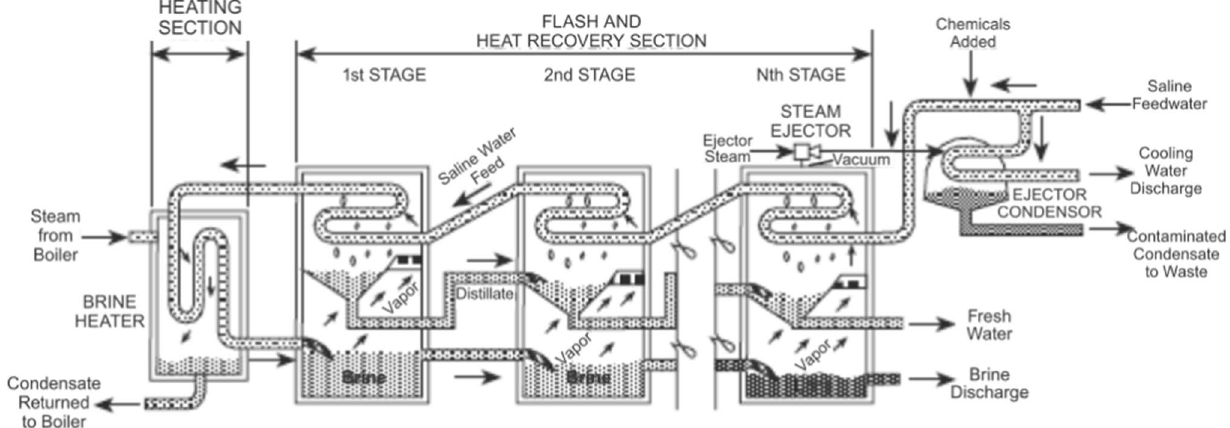
Fig. 14 The multi-stage flash (MSF) process for producing freshwater (El-Ghonemy